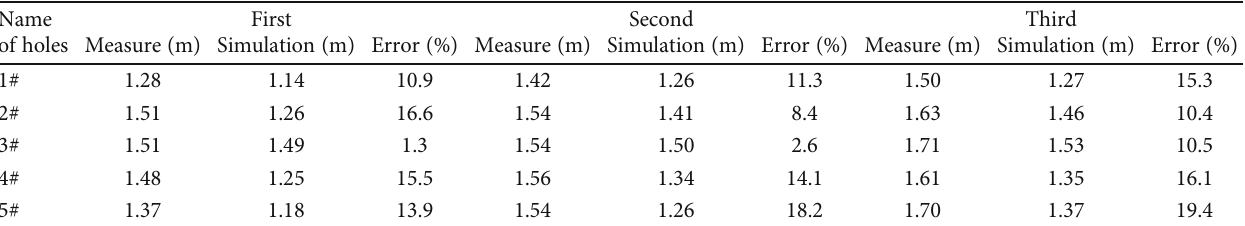
Table 2: Comparison between the measured and simulated results of broken rock zones in surrounding rock. Name First Second of holes